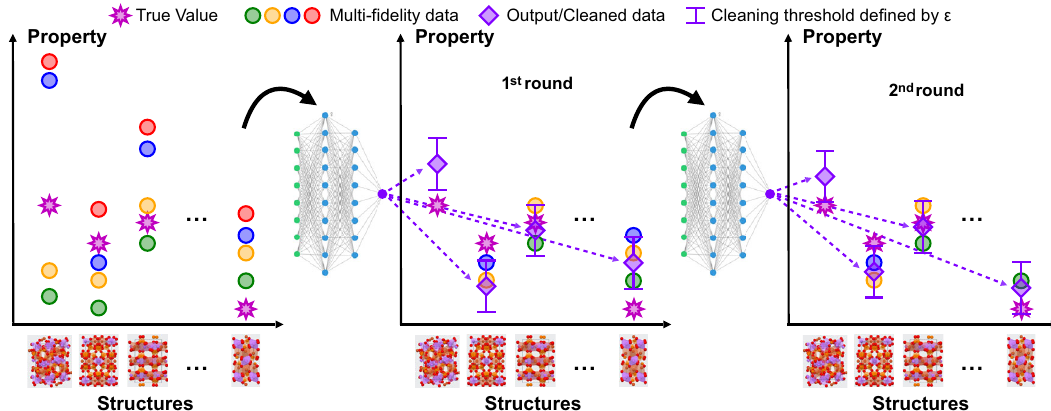
Fig. 4 Schematic representation of a typical data cleaning process. At each step, the multi- fi delity data (different property values for a given structure) are represented using different colors (the same as those adopted throughout the paper) and symbols (a star for the true experimental value and circles for the data with noise). Using the data, a predictive model (here symbolized by a neural network) is trained and predictions are made. The low- fi delity data which are too far (i.e., outside the interval de fi ned by the cleaning threshold ϵ ) from the output of the predictive model are replaced by the latter values. After this cleaning step, the procedure can be repeated until 4. onion : the training data consists of, fi rst, the combination of all fi ve datasets (P, H, S, G, and E) and, then, those obtained by removing one dataset at a time in a selected sequence (e.g., PHSGE → PHSE → PSE → GE → E as illustrated in Fig. 3b).